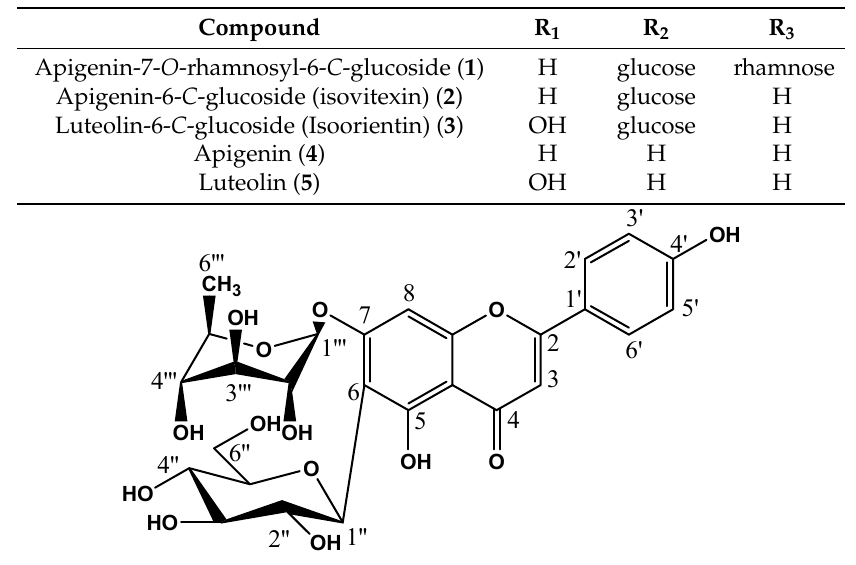
Figure 1. Chemical structures of the isolated compounds from Erythrina crista-galli . Compound 1 : apigenin-7- O -rhamnosyl-6- C -glucoside.